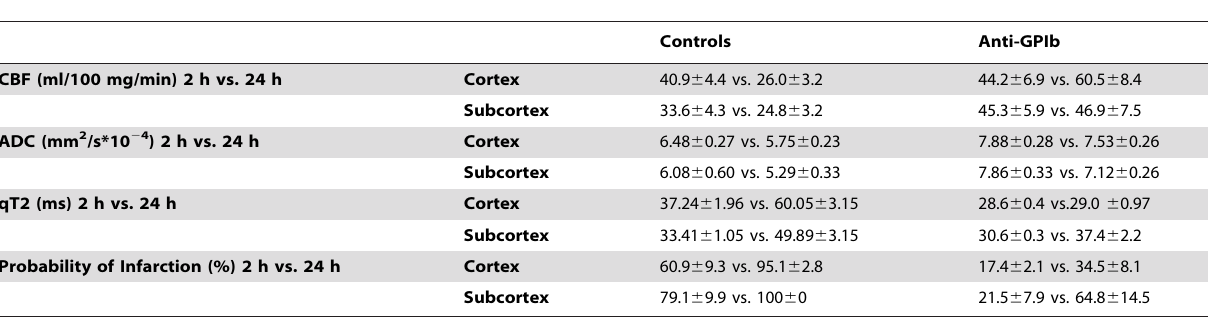
Table 1. All outcome measures per group, time point and location.